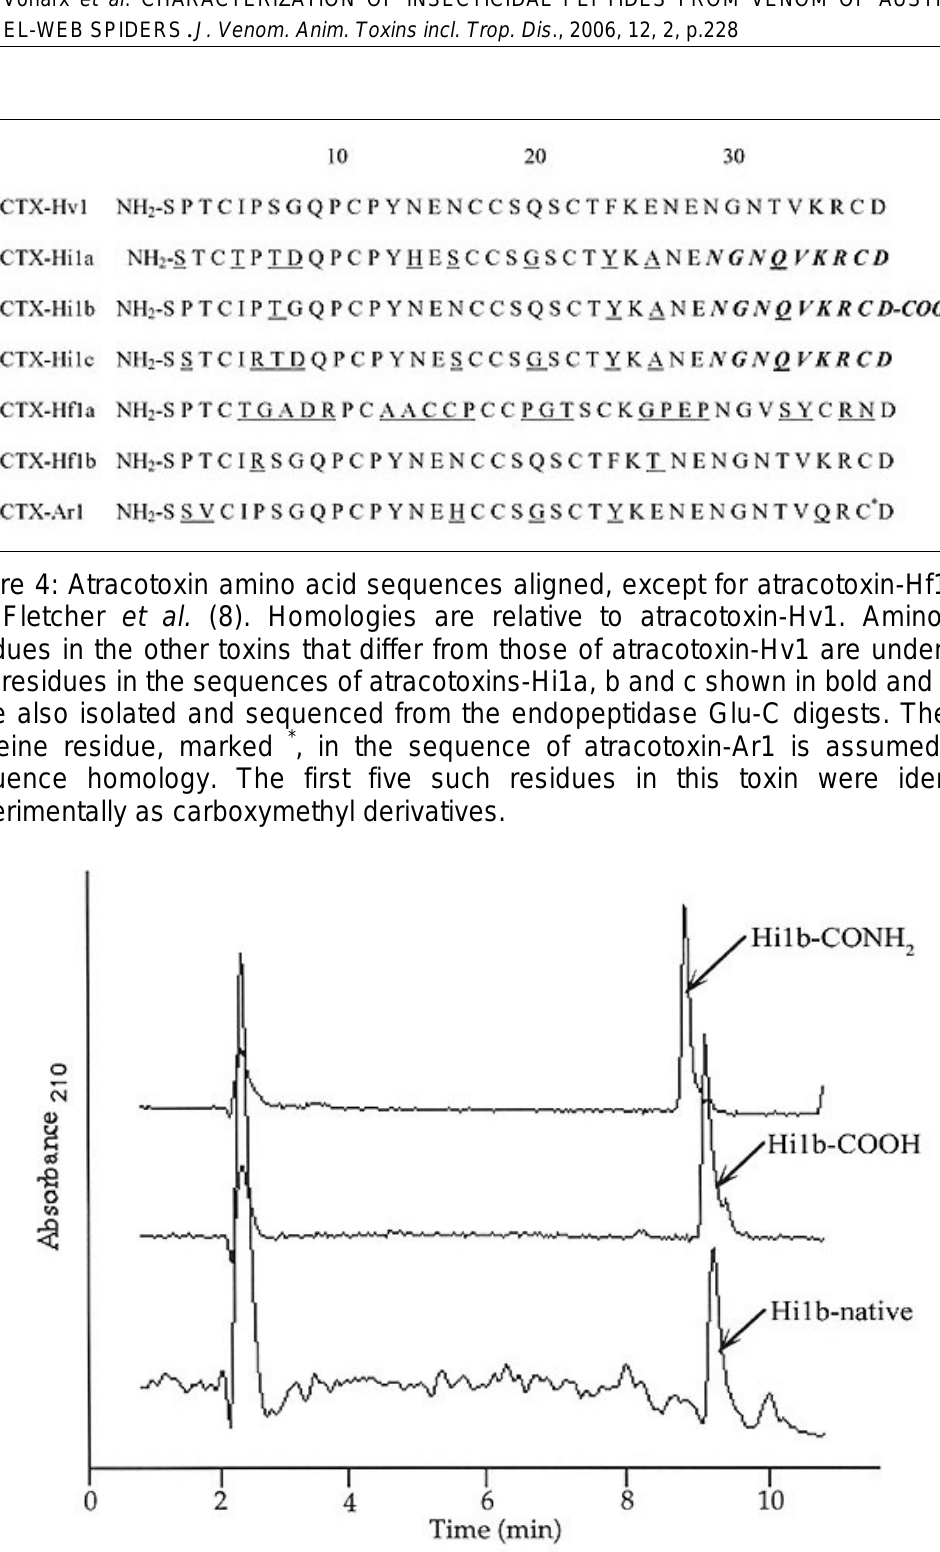
Figure 5: Comparison by reversed phase HPLC of two synthetic and one native endopeptidase Glu-C fragments of atracotoxin-Hi1b. One of the synthetic peptides is in the terminal amide form and the other has a carboxyl